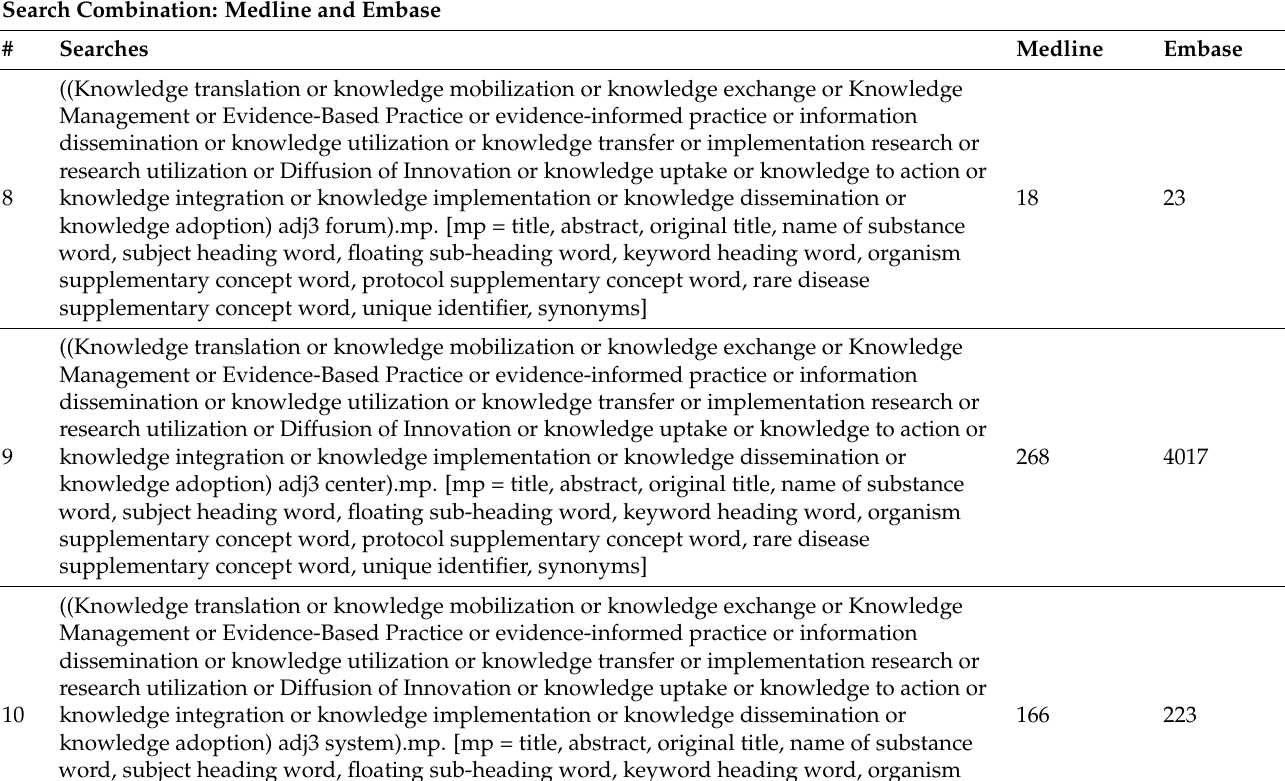
Table A1. Cont. Search Combination: Medline and Embase # Searches ((Knowledge translation or knowledge mobilization or knowledge exchange or Knowledge Management or Evidence-Based Practice or evidence-informed practice or information dissemination or knowledge utilization or knowledge transfer or implementation research or research utilization or Diffusion of Innovation or knowledge uptake or knowledge to action or 18 8 knowledge integration or knowledge implementation or knowledge dissemination or word, subject heading word, floating sub-heading word, keyword heading word, organism supplementary concept word, protocol supplementary concept word, rare disease supplementary concept word, unique identifier, synonyms] ((Knowledge translation or knowledge mobilization or knowledge exchange or Knowledge Management or Evidence-Based Practice or evidence-informed practice or information dissemination or knowledge utilization or knowledge transfer or implementation research or research utilization or Diffusion of Innovation or knowledge uptake or knowledge to action or 9 knowledge integration or knowledge implementation or knowledge dissemination or word, subject heading word, floating sub-heading word, keyword heading word, organism supplementary concept word, protocol supplementary concept word, rare disease supplementary concept word, unique identifier, synonyms] ((Knowledge translation or knowledge mobilization or knowledge exchange or Knowledge Management or Evidence-Based Practice or evidence-informed practice or information dissemination or knowledge utilization or knowledge transfer or implementation research or research utilization or Diffusion of Innovation or knowledge uptake or knowledge to action or 10 knowledge integration or knowledge implementation or knowledge dissemination or 166 word, subject heading word, floating sub-heading word, keyword heading word, organism supplementary concept word, protocol supplementary concept word, rare disease supplementary concept word, unique identifier, synonyms] ((Knowledge translation or knowledge mobilization or knowledge exchange or Knowledge Management or Evidence-Based Practice or evidence-informed practice or information dissemination or knowledge utilization or knowledge transfer or implementation research or research utilization or Diffusion of Innovation or knowledge uptake or knowledge to action or 11 knowledge integration or knowledge implementation or knowledge dissemination or word, subject heading word, floating sub-heading word, keyword heading word, organism supplementary concept word, protocol supplementary concept word, rare disease supplementary concept word, unique identifier, synonyms] ((Knowledge translation or knowledge mobilization or knowledge exchange or Knowledge Management or Evidence-Based Practice or evidence-informed practice or information dissemination or knowledge utilization or knowledge transfer or implementation research or research utilization or Diffusion of Innovation or knowledge uptake or knowledge to action or 12 knowledge integration or knowledge implementation or knowledge dissemination or substance word, subject heading word, floating sub-heading word, keyword heading word, organism supplementary concept word, protocol supplementary concept word, rare disease supplementary concept word, unique identifier, synonyms] ((Knowledge translation or knowledge mobilization or knowledge exchange or Knowledge Management or Evidence-Based Practice or evidence-informed practice or information dissemination or knowledge utilization or knowledge transfer or implementation research or research utilization or Diffusion of Innovation or knowledge uptake or knowledge to action or knowledge integration or knowledge implementation or knowledge dissemination or subject heading word, floating sub-heading word, keyword heading word, organism supplementary concept word, protocol supplementary concept word, rare disease supplementary concept word, unique identifier,